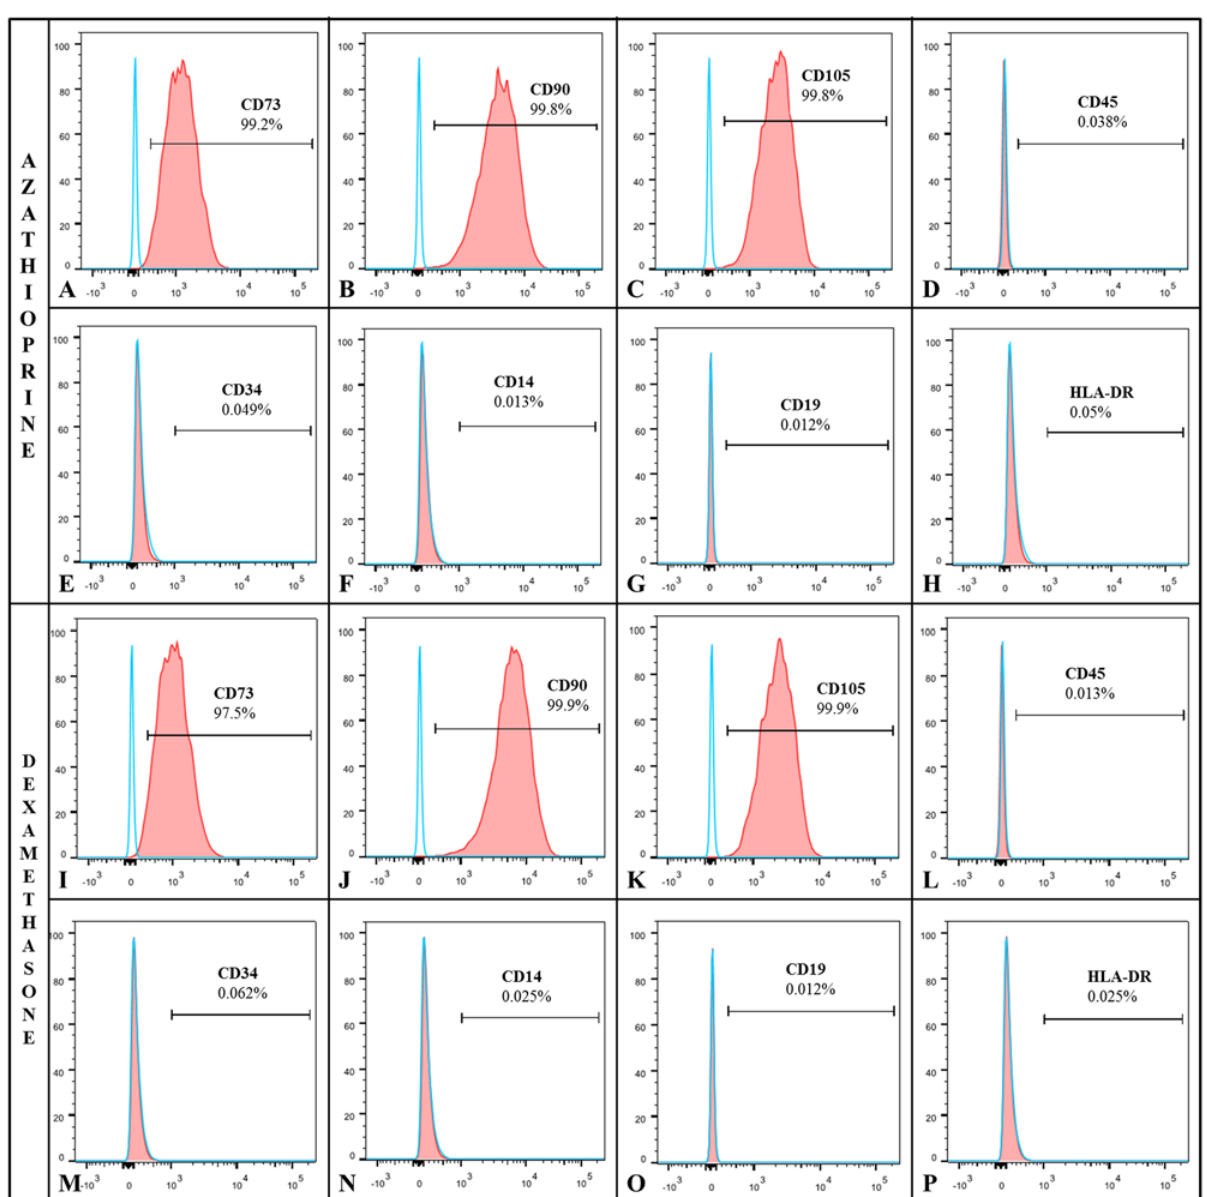
Fig 2. MSC immunophenotyping under DEX or AZA treatments. MSCs were cultured for 7 d under AZA or DEX treatments, and immunophenotyping analysis was performed in order to ensure that the cells still maintained their stemness. MSCs under AZA (A-H) or DEX (I-Q) treatments presented a positive signal for CD73, CD90 and CD105 but no signal for CD45, CD34, CD14, CD19 and HLA-DR markers ( n =